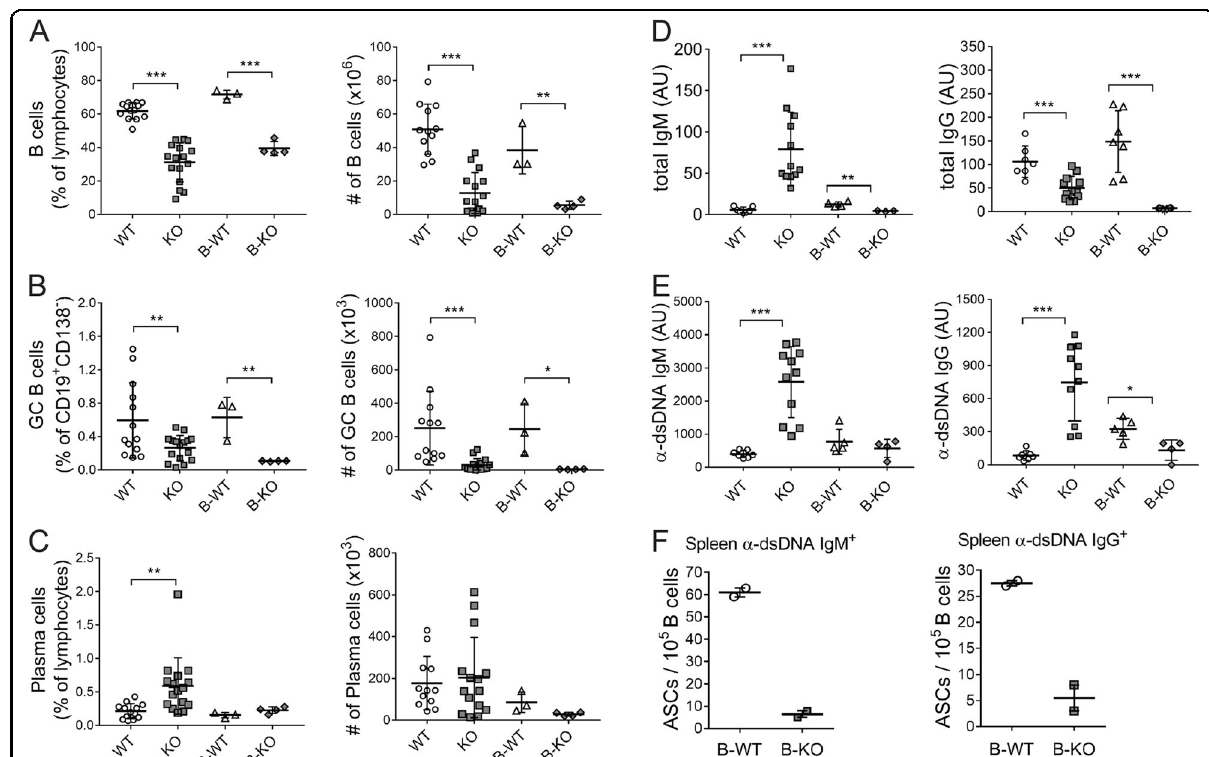
Fig. 4 B cell-autonomous functions of Bach2. Rag2 − / − mice were reconstituted with μ MT BM cells plus either Bach2 KO or WT BM cells to generate B-KO and B-WT chimeric mice. Fifteen weeks after BM reconstitution, sera and spleen cells were harvested from the recipients and assayed by FACS a – c , ELISA d , e and ELISPOT f . FACS pro fi les gated on CD19 + CD138 - cells and live lymphocytes are used to enumerate FAS + GL7 + GC B cells and CD19 - CD138 + plasma cells, respectively b , c . The data shown were pooled from three independent experiments. a – e or are representative of two independent experiments f and are displayed as the means ± SEMs, with symbols representing the values of individual mice. * p < 0.05, ** p < 0.01 and *** p < 0.001 by Student ’ s t